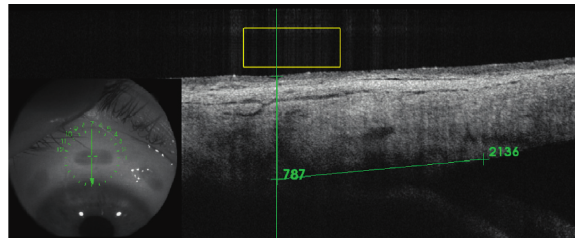
Figure 1: OCTscan of a patient three months after UCP—distance from limbus to scleral mark was measured (2136 μ m) to determine preoperative thickness.